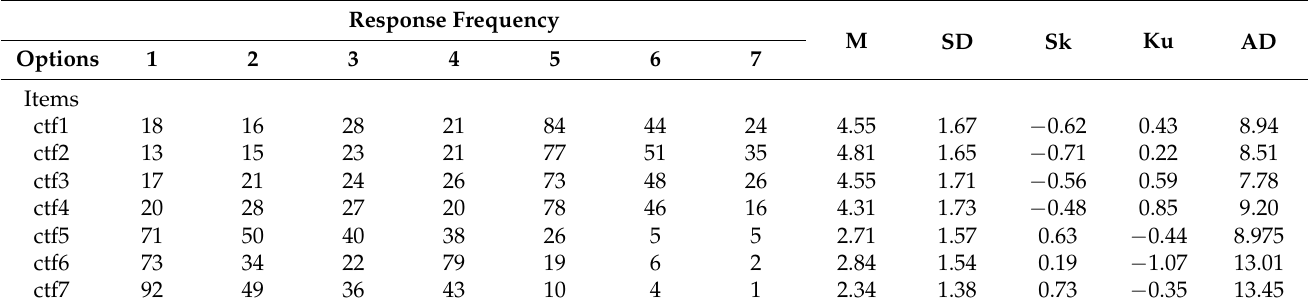
Table 2. Item analysis: descriptive and frequency for items.